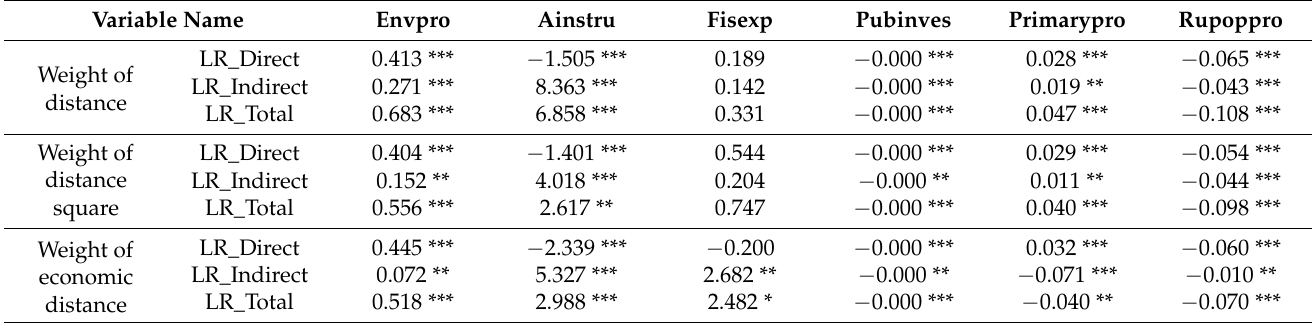
Table 5. Calculation results of direct and indirect effects under different spatial weight